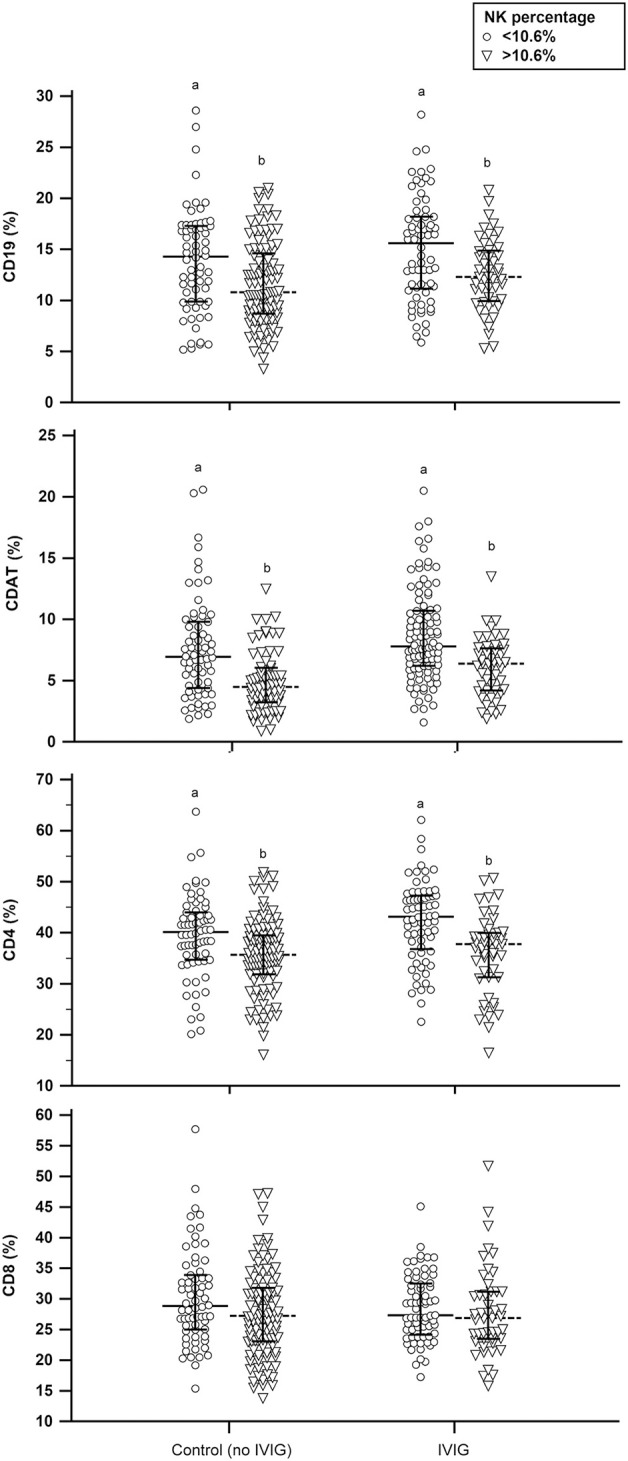
The distribution of peripheral mononuclear cell profiles between high and low percentage of CD56+CD16+ NK cells in intravenous immunoglobulin (IVIG) and non-IVIG groups. Different letters in the same subset figure indicate a significant difference, P < 0.01, using Mann-Whitney U-test.